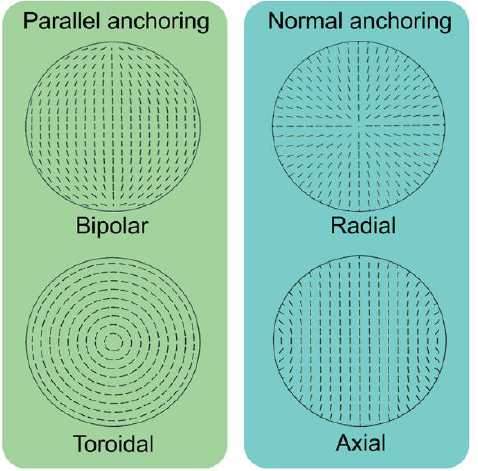
Figure 18. Schematic representation of four possible director configurations in a droplet: bipolar, toroidal, radial and axial.